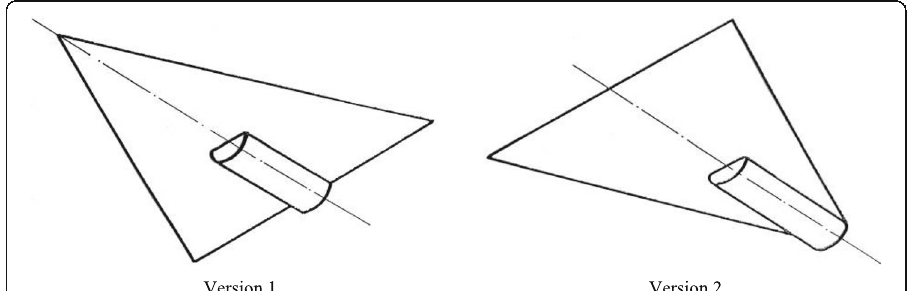
Fig. 3 The simple configurations of flat wings with air-breathing